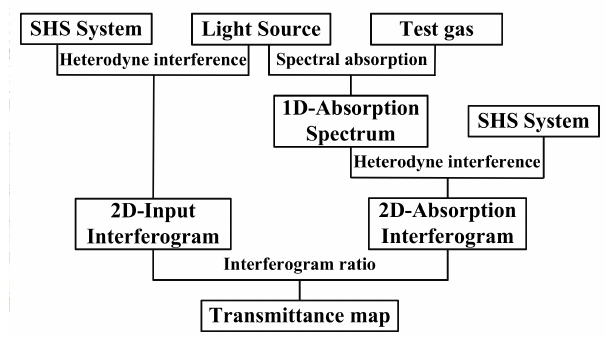
Figure 3. Flowchart of the visual e-nose system.